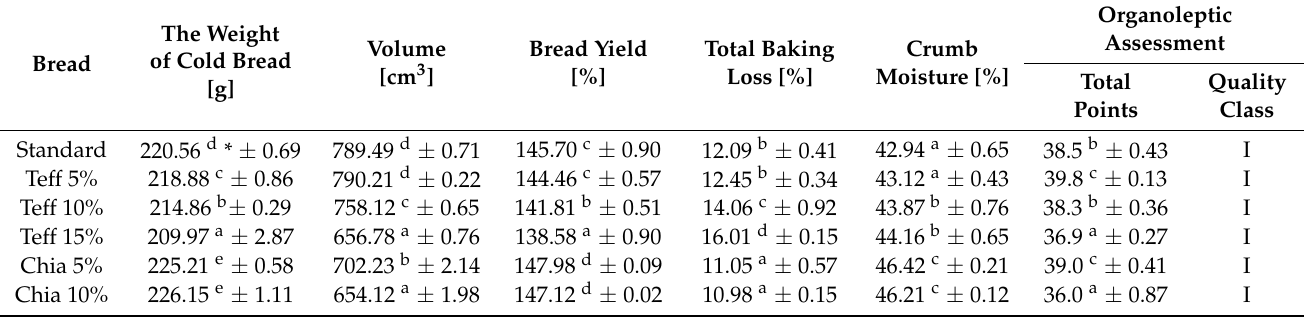
Table 2. Assessment of the quality of baked bread with a varied proportion of teff flour on the baking day. The Bread